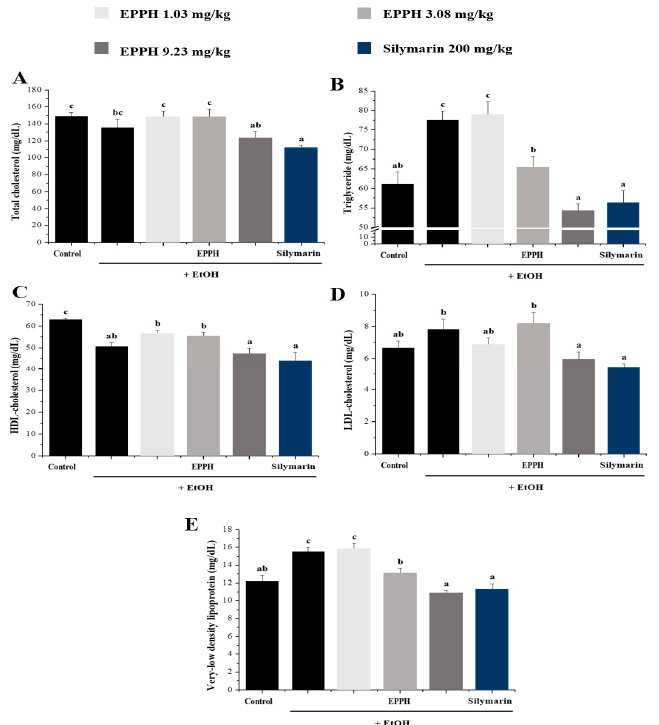
Figure 3. Effects of EPPH on ( A ) total cholesterol (TC), ( B ) triglyceride (TG), ( C ) HDL-cholesterol (HEL-C), and ( D ) LDL-cholesterol ( E ) (LDL-C) mice fed EtOH for 42 days. Silymarin is a positive control. The data are expressed as the mean ± SD ( n = 10), and different letters (c > b > a) indicate a significant difference at p < 0.05, as determined by Duncan’s multiple-range test.